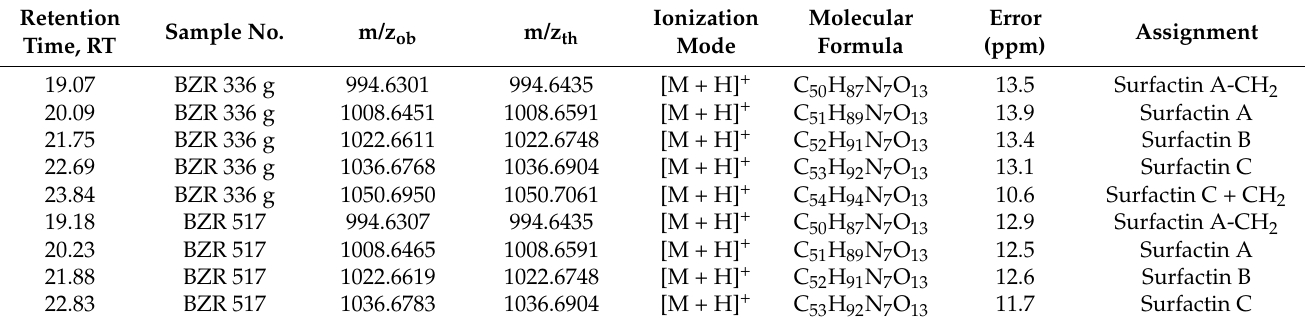
Table 1. Observed (m/z ob ) and theoretical (m/z th ) masses of mass signals obtained for surfactin, iturin, and their homologues by HPLC-ESI+